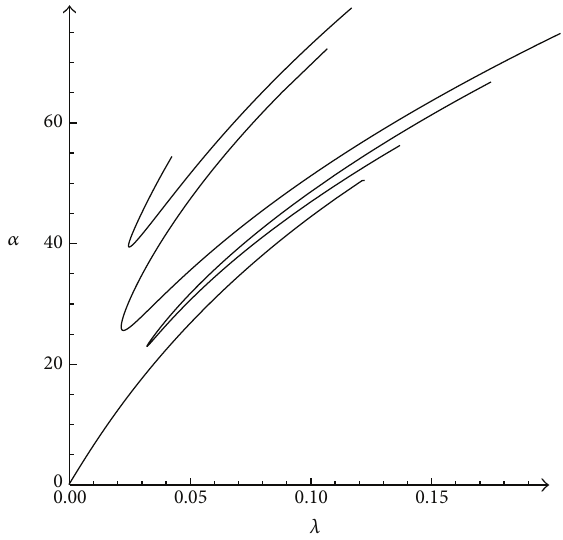
Figure 4: The bifurcation diagram for Example 1